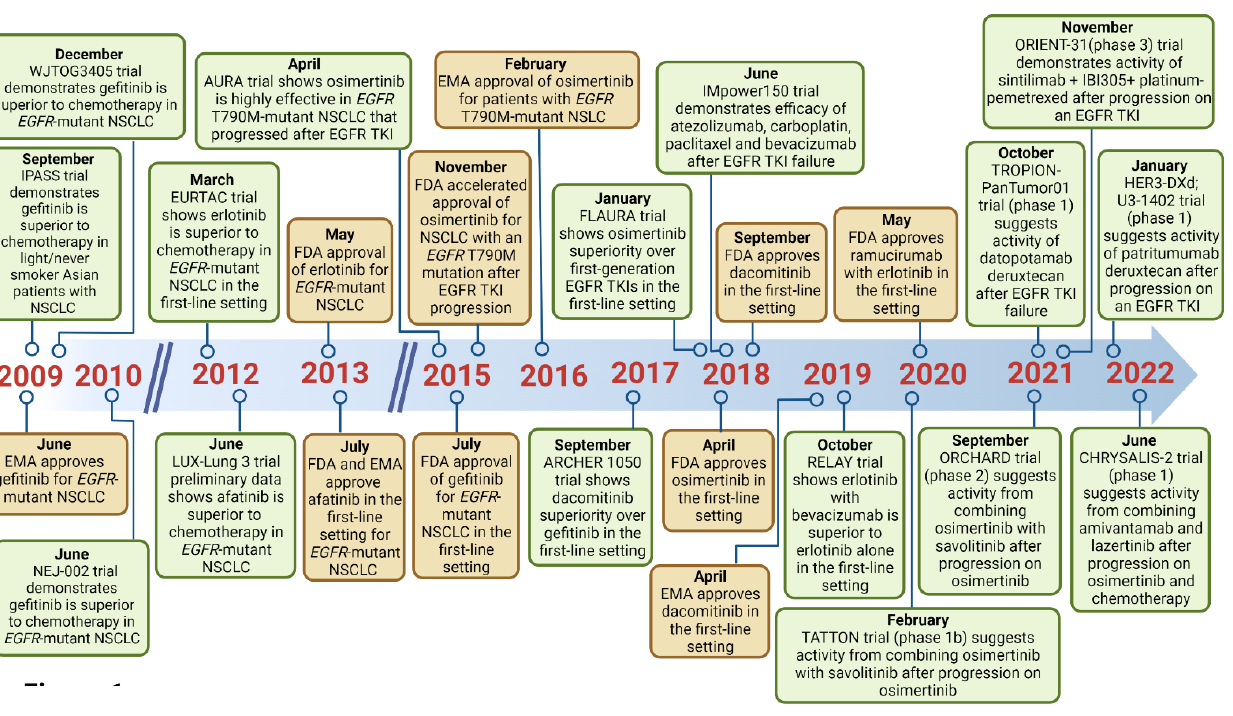
Figure 1. Timeline depicting the publication of landmark trials on anti-EGFR TKIs, approval by the FDA and EMA, and publication of data pertaining novel therapies; EMA, European Medicines Agency; FDA, Food and Drugs Administration; TKIs, tyrosine kinase inhibitors. Created with BioRender.com, accessed on 8 January 2023.